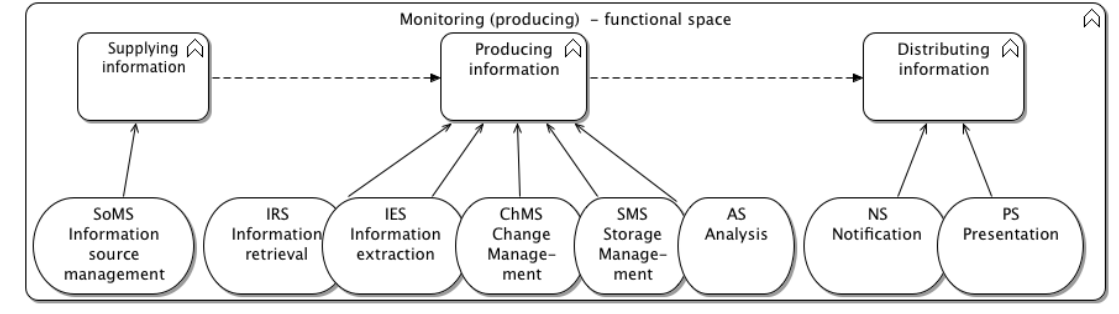
Figure 3. Internal information logistics of monitoring node and corresponding EduMon